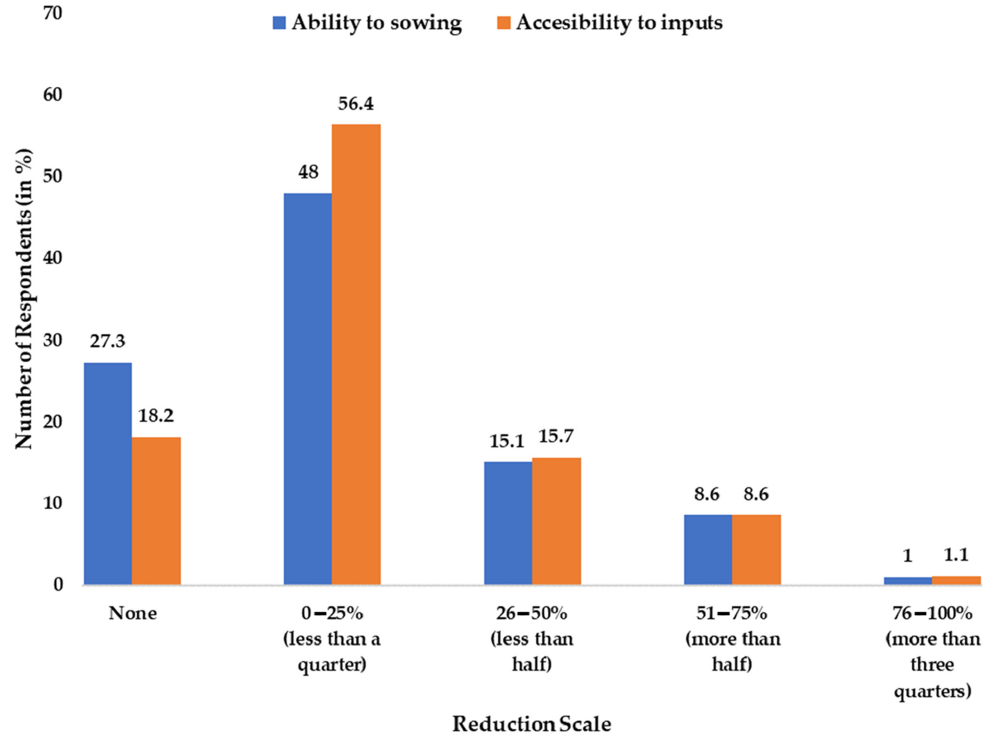
Figure 4. Reduction in ability to plant and accessibility to inputs among the respondents during the season ( n = 802).